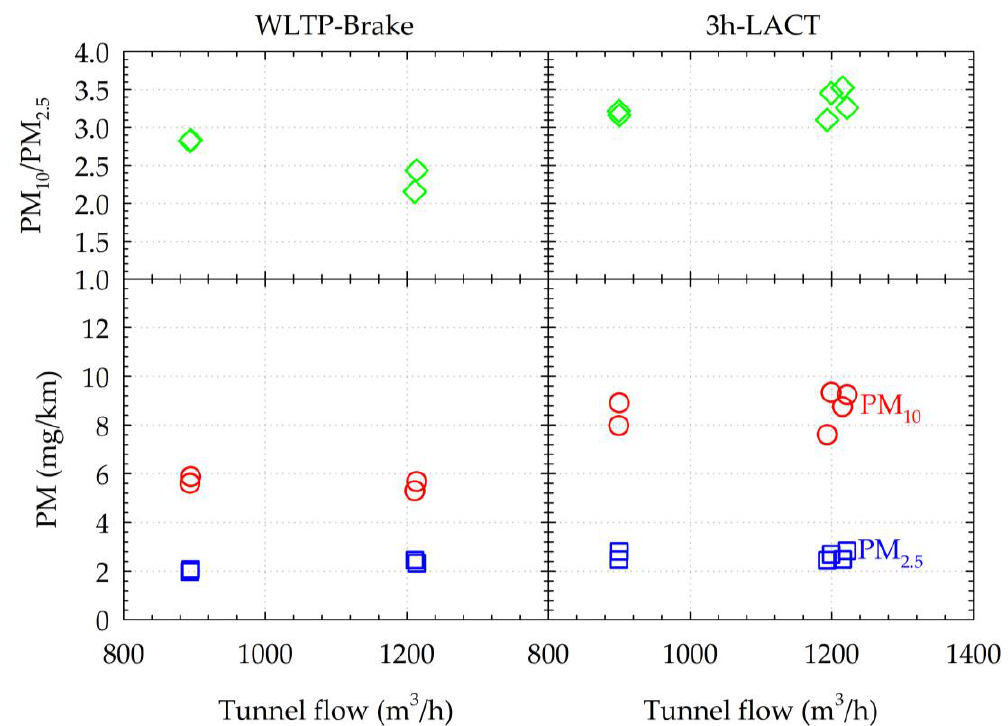
Figure 4. PM 10 (red dots on bottom panels), PM 2.5 (blue dots on bottom panels) emissions and ratio of PM 10 to PM 2.5 (green dots on top panels) over the WLTP-Brake ( left-hand panels ) and 3h-LACT ( right-hand panels ) as a function of the tunnel flow employed (horizontal axis).